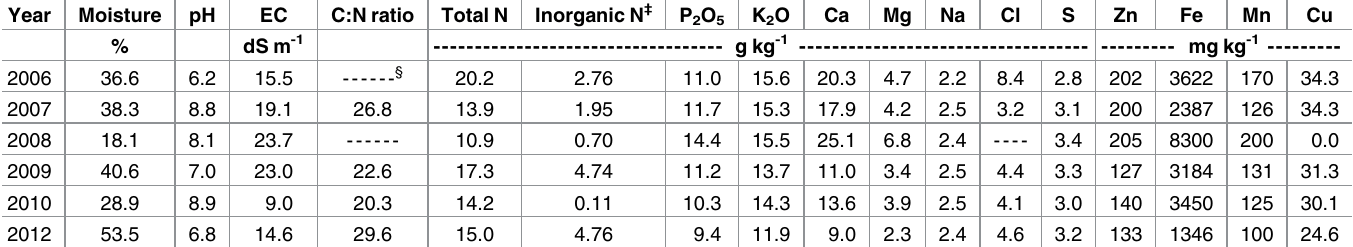
Table 4. Chemical characteristic of the beef manure added to the researchplots from 2006 to 2012 †